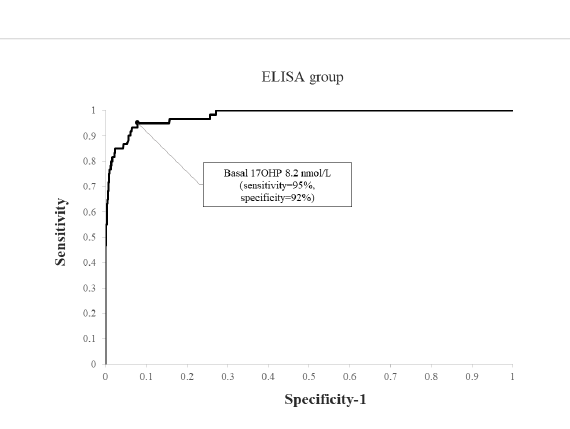
FIGURE 4 ROC curve analysis for determination of optimal basal 17OHP threshold in ELISA (using a post-CST 17OHP cutoff > 40 nmol/L for the diagnosis of